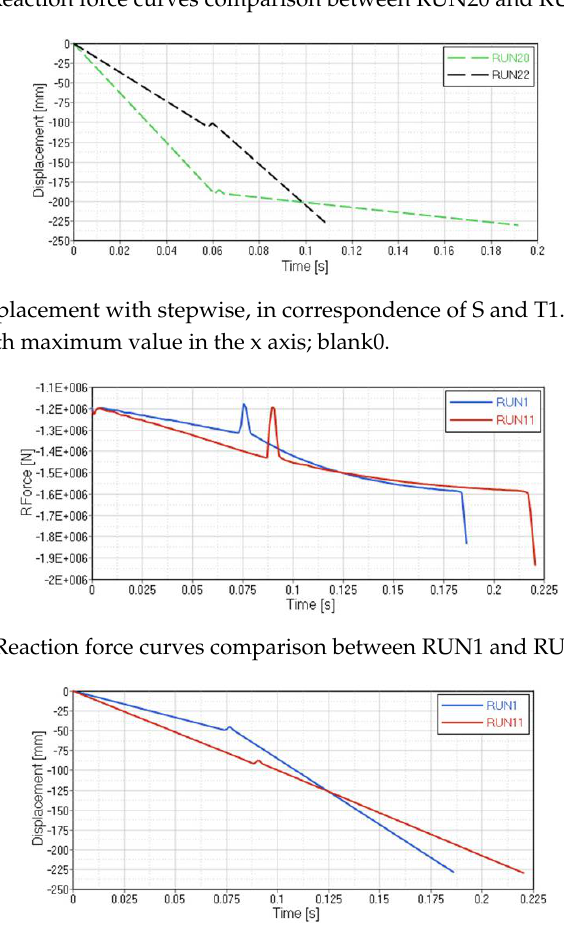
Figure 16. Punch displacement with stepwise, in correspondence of S and T1. TT represents the last point of the curve with maximum value in x axis; blank1.